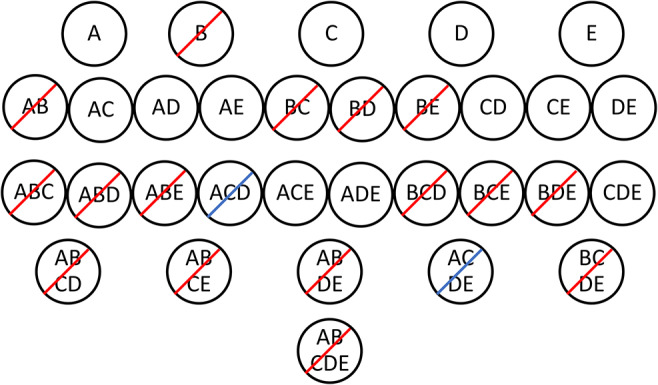
Frequent itemset generation from the Table 3 dataset using the Apriori algorithm. Each candidate itemset is represented by a black circle. The itemsets with a red slash are eliminated after examining the top row of itemsets and comparing the support of each itemset to the minimum support of 0.4. [B] has a support of 0.33 and therefore all of its supersets must have a support less than or equal to 0.33. All remaining itemsets in the second row are frequent with a support >0.4. Itemsets with a blue slash are eliminated after calculating the support for three-item itemsets.